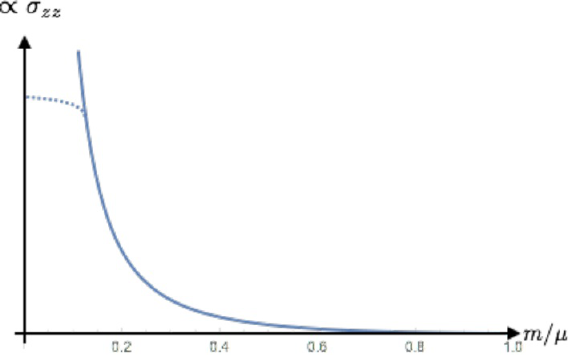
Figure 3 . The interpolating function between the relativistic and non-relativistic case for the conductivity: (cid:27) zz vs. m=(cid:22) . The solid line is the estimation without the inter-cone transition. In the massless limit, the conductivity is suppressed by the inter-cone transition (dotted